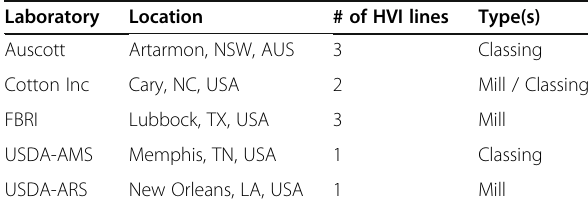
Table 3 Mean values for six cotton samples and 30 tests